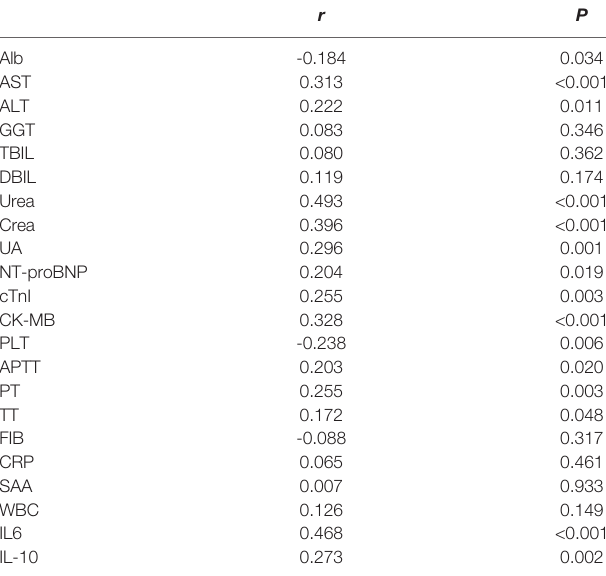
TABLE 2 | The correlation between GDF15 and organ damage markers and in fl ammatory indexes. Alb